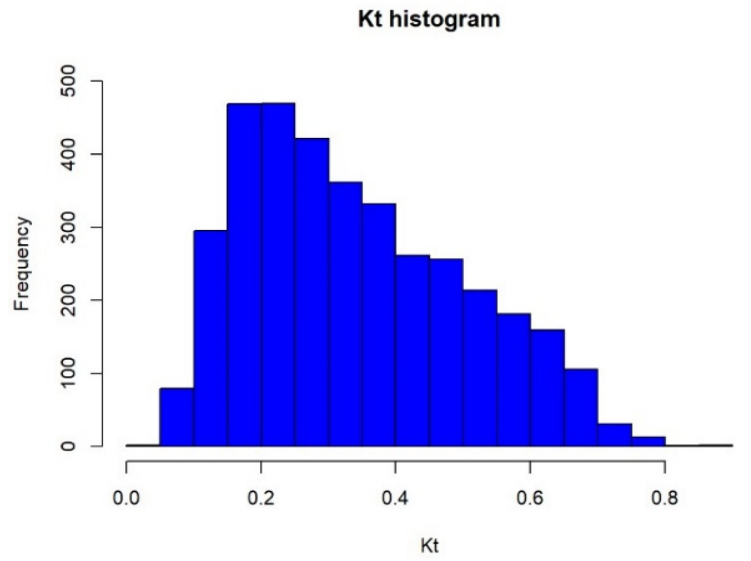
Figure 4. Kt index Figure 4. Kt index distribution.